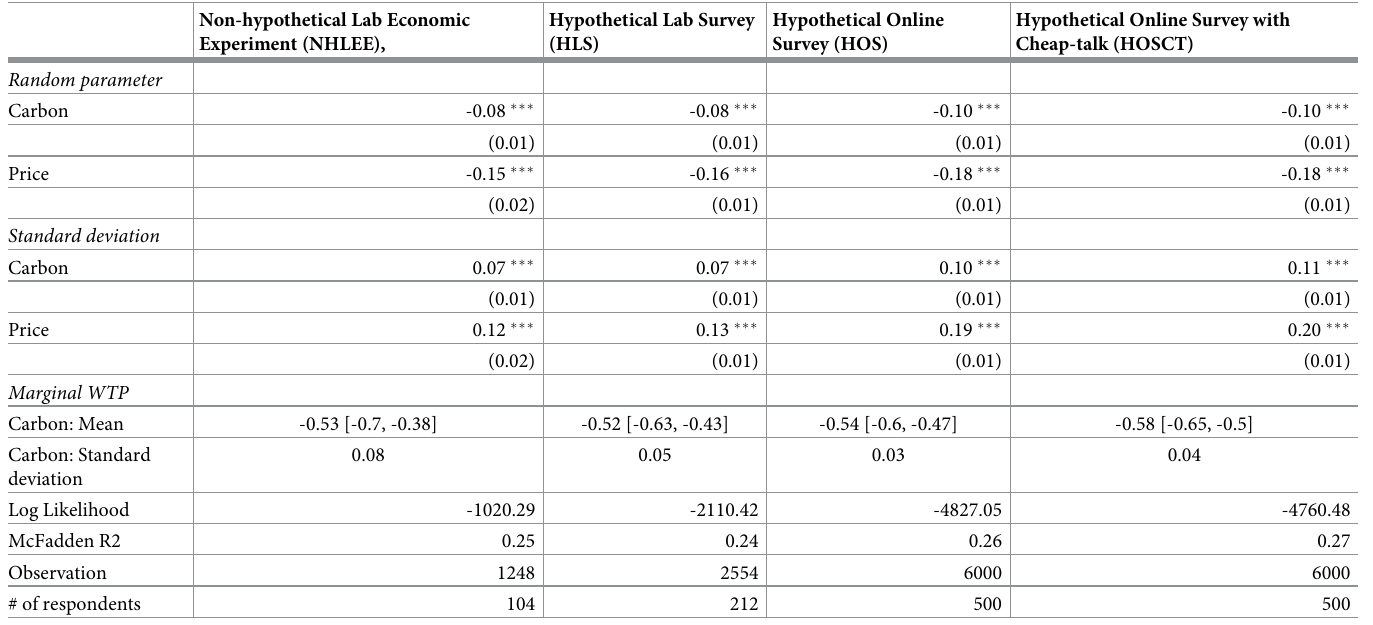
Table 5. The random parameter logit regression results in the main effect (Model 1). Non-hypothetical Lab Economic Experiment